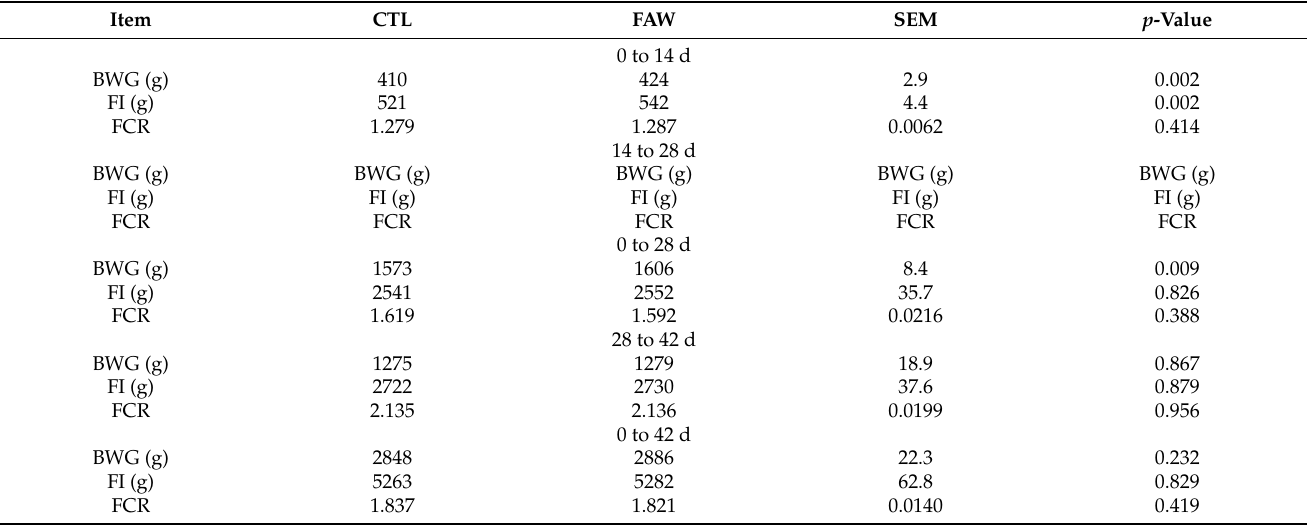
Table 5. Live performance of broilers provided feed and water (FAW) nutrient access in the hatching basket compared to a control (CTL) from 0 to 42 d post-hatch 1